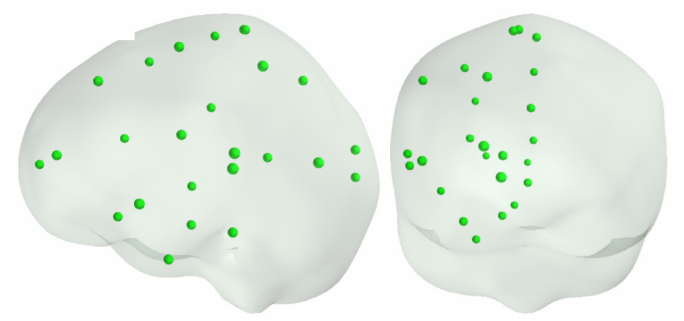
Figure 3. Locations of selected 25 sources used in [13], covering the left hemisphere. A corresponding set of points was also used on the right hemisphere.